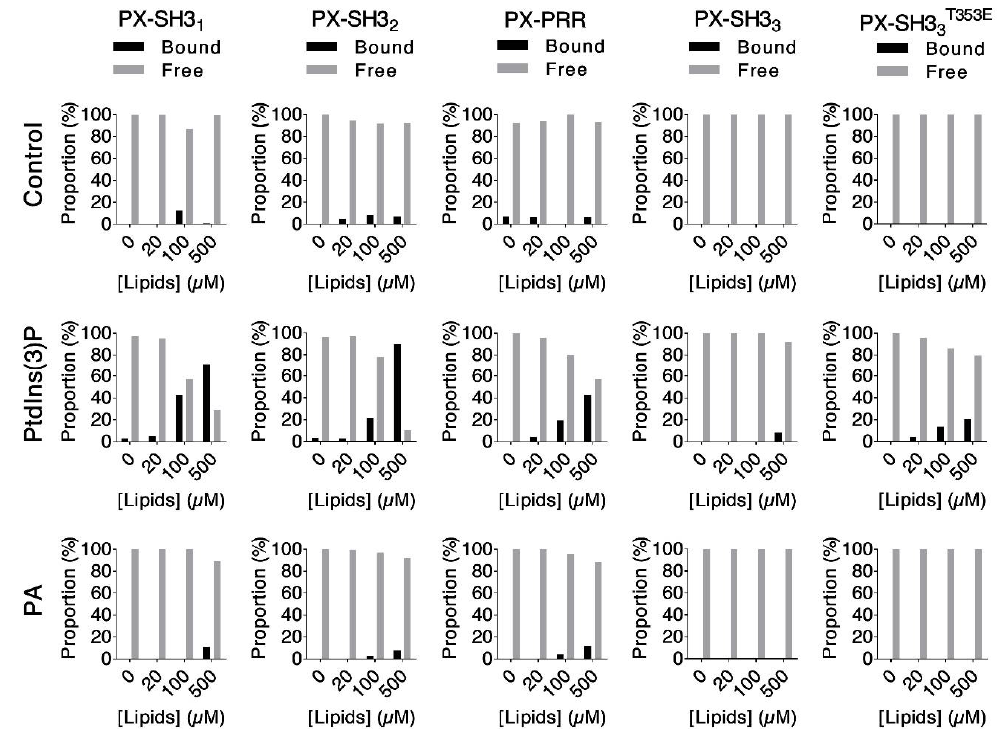
Figure 8. Liposome co-sedimentation assays: The Tks4 fragments PX–SH3 1 , PX–SH3 2 , PX–PRR, and PX–SH3 3 at a final concentration of 1 µ M were titrated with phospholipid-free control liposomes (top panels), liposomes containing 5% (mol/mol) PtdIns(3)P (middle panels), or liposomes containing 5% (mol/mol) PA (bottom panels). Liposomes with bound proteins were separated from the soluble fraction via centrifugation. Samples were analyzed via SDS-PAGE and Coomassie staining (Figure S6). The percentages of fragments recovered in the bound (black) and free (gray) fractions were determined via gel densitometry. Only PtdIns(3)P-containing liposomes showed concentration-dependent association with Tks4 fragments. This effect was reduced in the case of PX–PRR and almost totally abolished in the case of PX–SH3 3 , showing that both the PRR and the third SH3 domain have autoinhibitory roles in Tks4. Although the PX–SH3 3T353E mutant showed slightly increased PtdIns(3)P liposome binding, it seems very unlikely that the phosphorylation of Thr353 could be the regulatory mechanism responsible for Tks4 activation in vivo. None of the Tks4 fragments associated with control or PA-containing